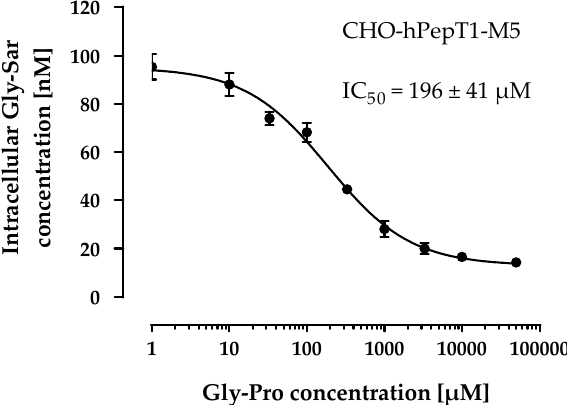
Figure 5. Concentration-dependent inhibition of the Gly-Sar uptake in the CHO-hPepT1-M5 clone by Gly-Pro. The data points represent the mean ± S.E.M. of three independent experiments with each concentration tested in sextuplets.